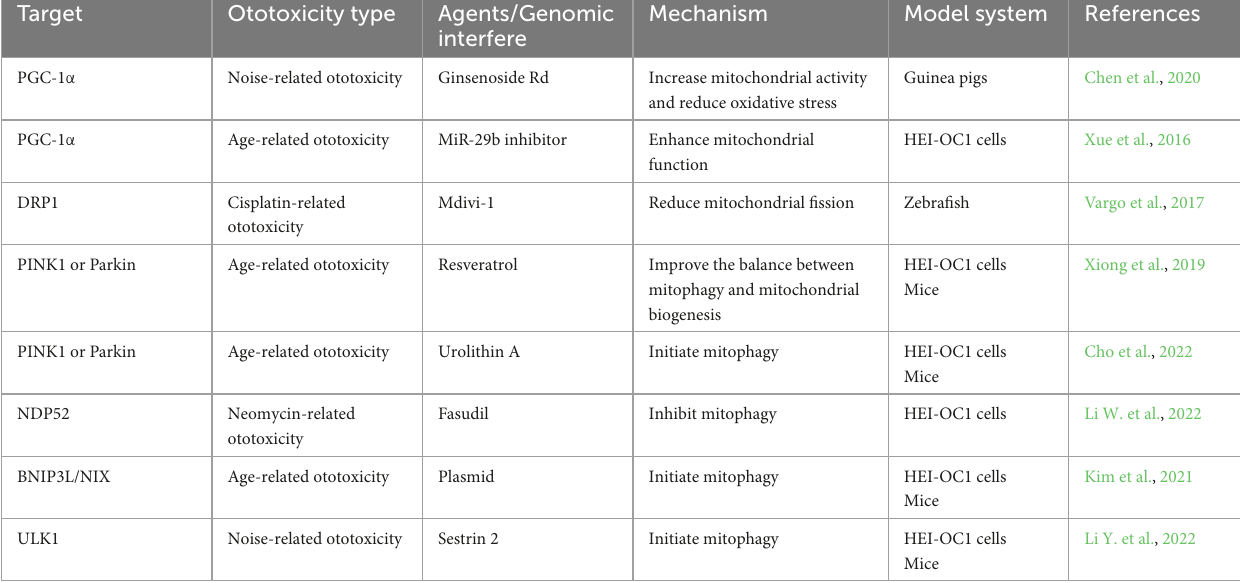
TABLE 1 Summary of potential targets for treating